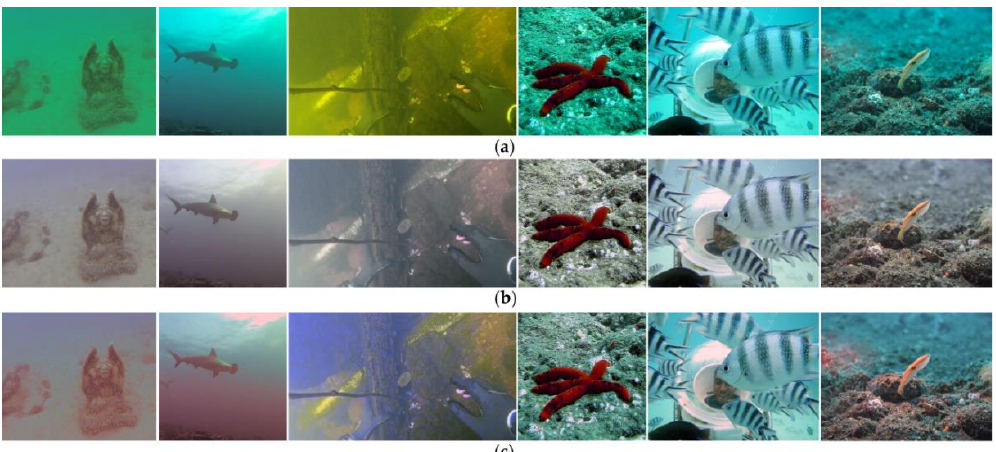
Figure 15. Comparisons on results obtained by the proposed method with and without linearization: ( a ) Raw underwater images, ( b ) Results with linearization, ( c ) Results without linearization.